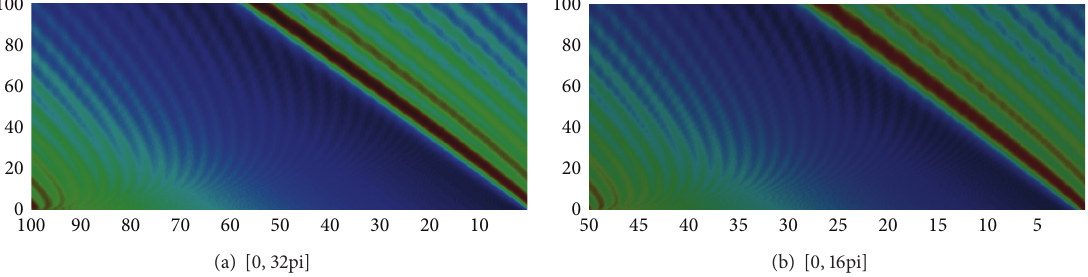
Figure 3: Time evolution for the hydrodynamics equation together with initial wave 𝑢 = tan (𝜃) sech 2 (𝑥 − 𝑐𝑡) + tan (𝜃) exp [𝑖𝑘(𝑥 − 𝑐𝑡)] , 𝜃 = 0.1 and ] = 0